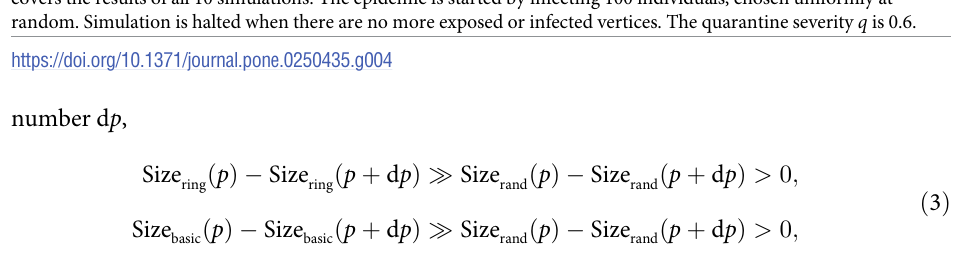
Fig 2 corresponds to the β = 0.05 column. As in Fig 2, The four uptake scenarios correspond to the four curves on each figure. For each parameter value, the plotted result is the median over 10 runs. The shaded region around the plot covers the results of all 10 simulations. The epidemic is started by infecting 100 individuals, chosen uniformly at random. Simulation is halted when there are no more exposed or infected vertices. The quarantine severity q is